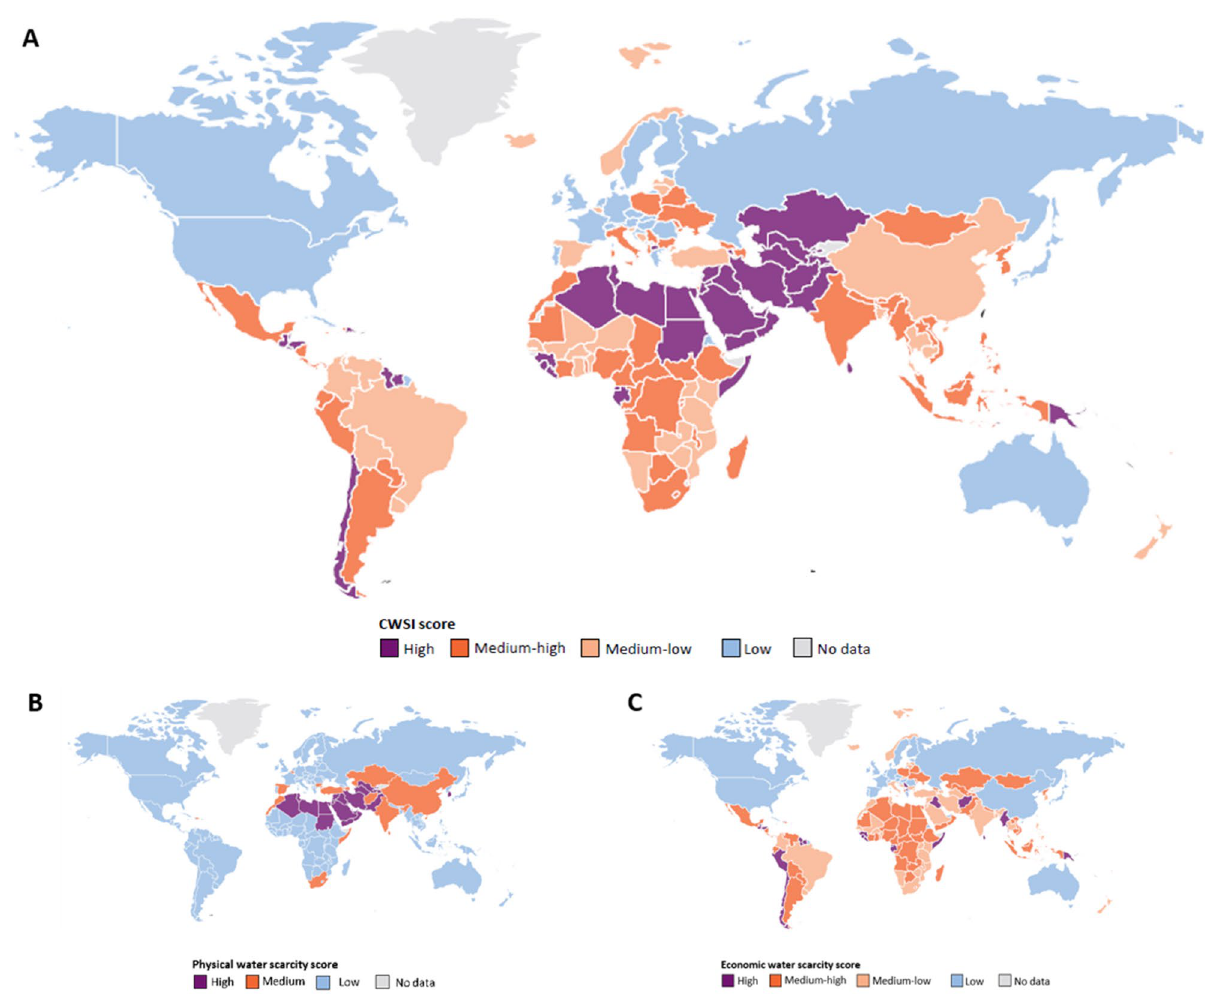
Figure 1. ( A ) Composite water scarcity index (CWSI) in 2017. Low, medium–low, medium–high and high scores correspond to intervals (0, 0.35), (0.35, 0.55), (0.55, 0.75), and (0.75, 1), respectively. ( B ) Physical water scarcity index in 2017. Low, medium, and high scores correspond to intervals (0, 0.2), (0.2, 0.4), and (0.4, 1), respectively. Thresholds are retrieved from the scientific literature[52,60–62]. ( C ) Economic water scarcity index in 2017. Low, medium–low, medium–high and high scores correspond to intervals (0, 0.30), (0.30, 0.50), (0.50, 0.70), and (0.70, 1), respectively. Thresholds are retrieved from the official documents related to the IWRM index 57 . The map was generated with D3.js (authors elaboration; https:// d3js. org Version